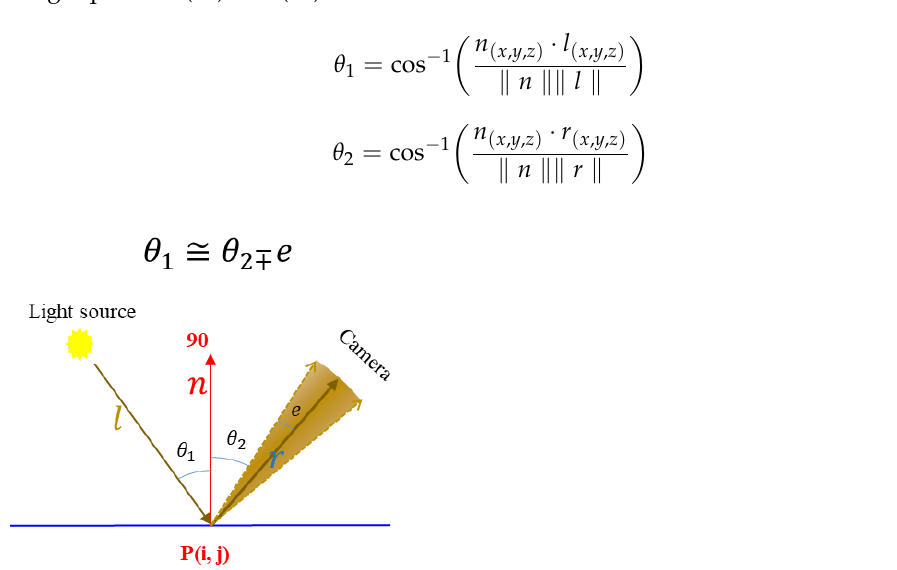
Figure 5. Removing shadow and specular reflection using the accurate geometry of the lighting system and object’s sparse 3D shape.